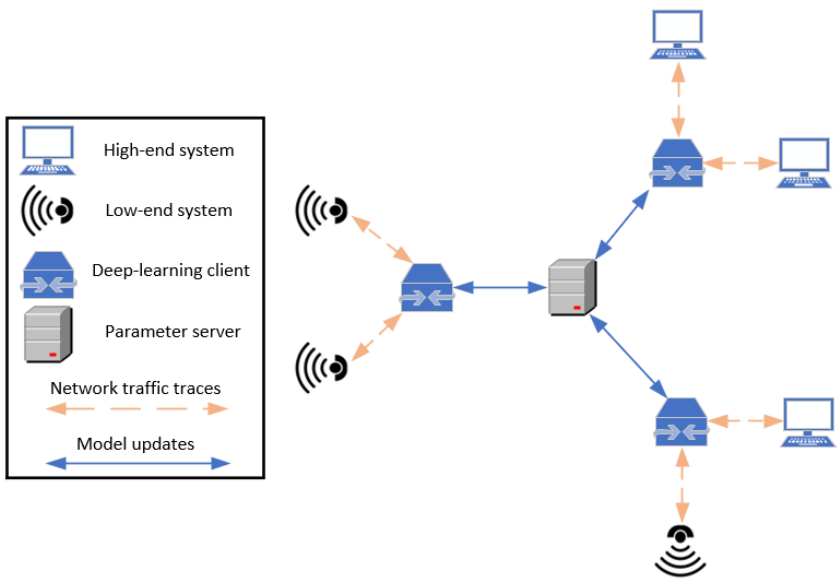
Figure 13. Federated learning in a network of devices.